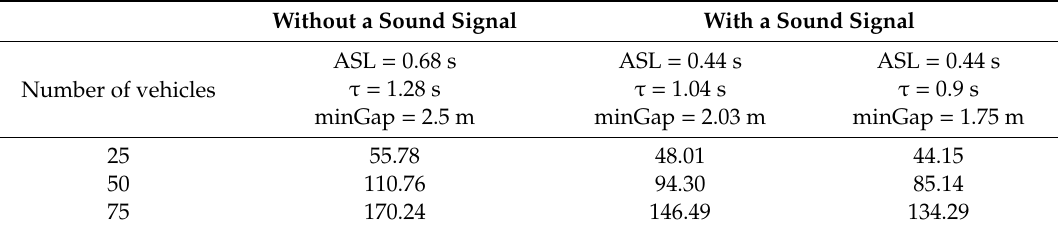
Table 2. The times where the last vehicle in the column left the simulated area after the tra ffi c lights turned